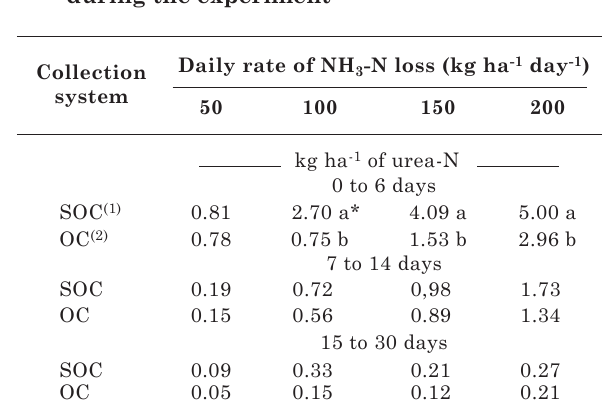
table 1. daily rates of nH 3 -n volatilization from urea applied onto sugarcane straw as estimated by two collection systems in different